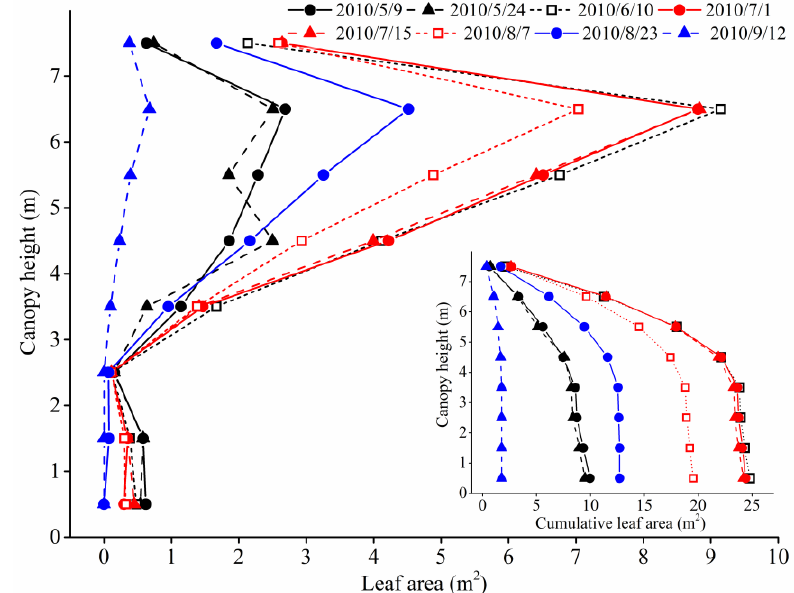
Figure 8. Variation of the leaf areas with canopy height of the sample tree at different dates. The inset shows the cumulative leaf areas distribution plotted against the canopy height of the sample tree at different dates. The date format at different times is “year/month/day”.